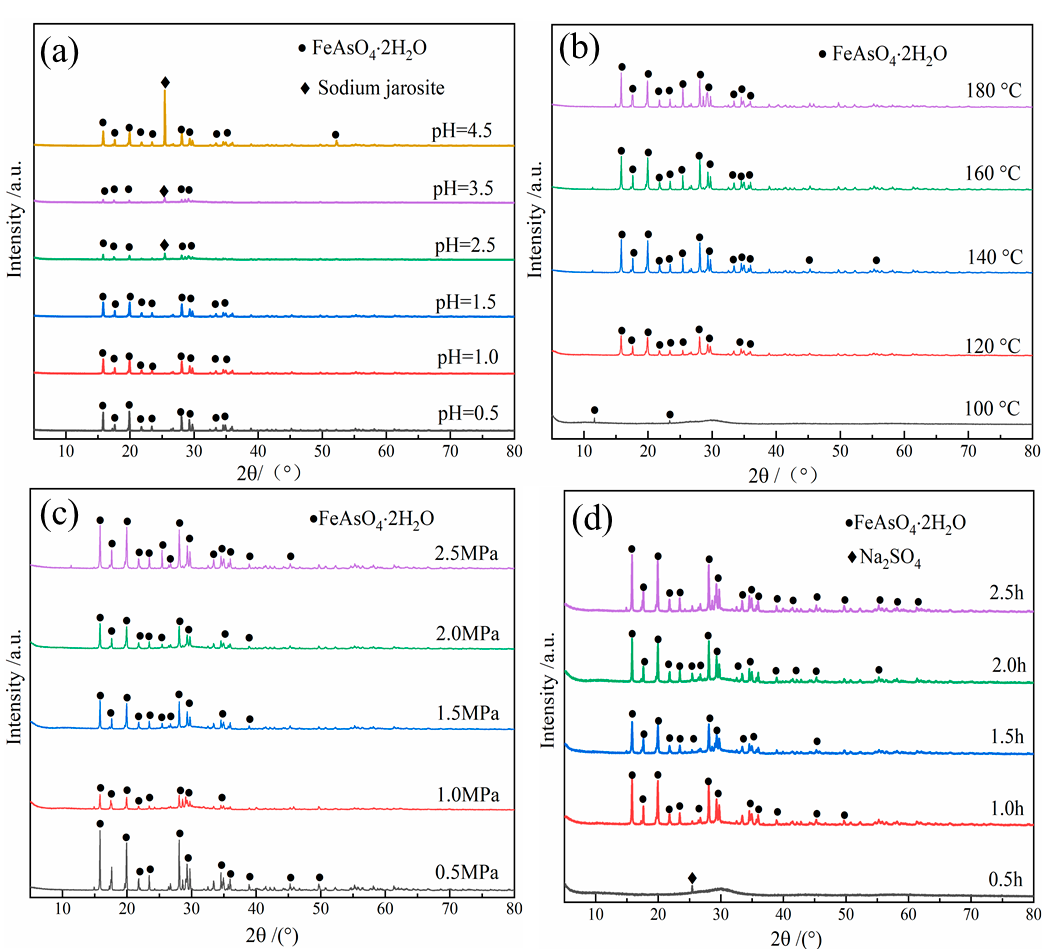
Figure 9. XRD patterns of precipitates at different precipitation conditions: ( a ) initial pH (Fe/As molar ratio of 1.3, temperature of 160 °C, precipitation time of 2 h and p O 2 of 2.5 MPa), ( b ) temperature (Fe/As ratio of 1.3, pH value of 1.0, precipitation time of 2 h and p O 2 of 2.5 MPa), ( c ) p O 2 (Fe/As ratio of 1.3, pH value of 1.0, reaction time of 2 h, temperature of 160 °C), ( d ) precipitation time (Fe/As ratio of 1.3, pH value of 1.0, p O 2 of 2.5 MPa, temperature of 160 °C).